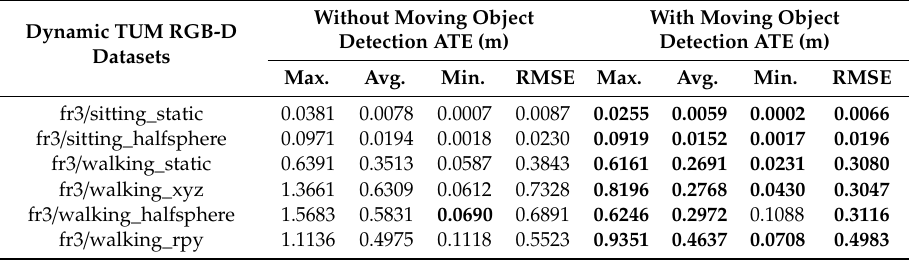
Table 3. ATE on the sitting and walking dynamic datasets of the proposed RGB-D SLAM with and without the moving object detection. The numbers in bold indicate that these terms are better than those of another